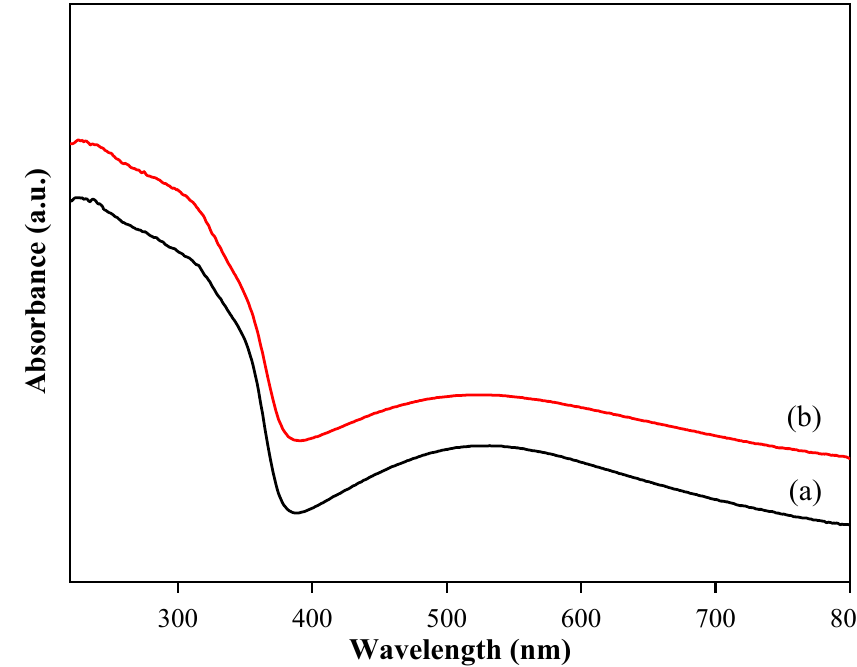
Figure 6. Absorption patterns for ( a ) CdSe–TiO 2 nanotube thin films subjected to 20 °C soaking temperature and ( b ) pure TiO 2 nanotube thin films.